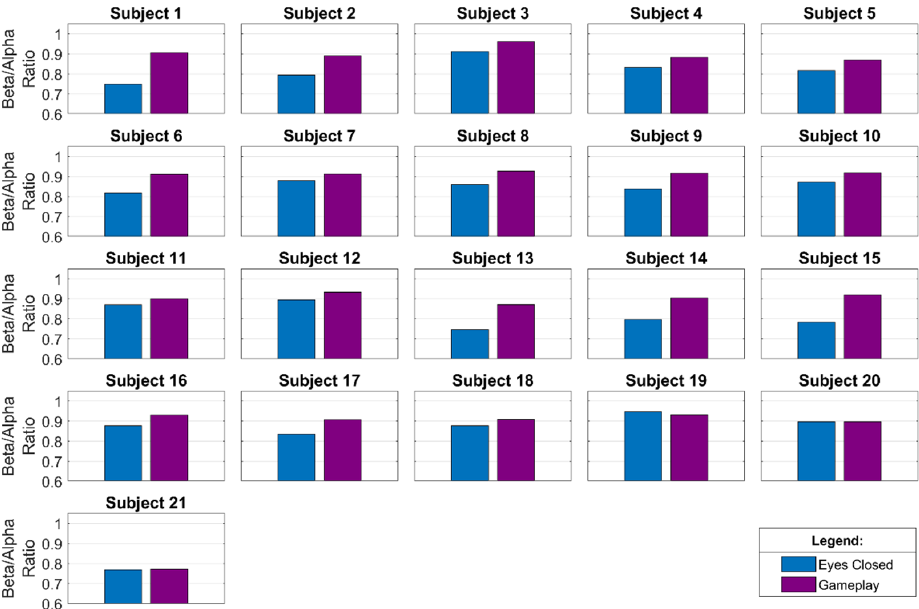
Figure 11. The beta/alpha ratio during the rest and gameplay.